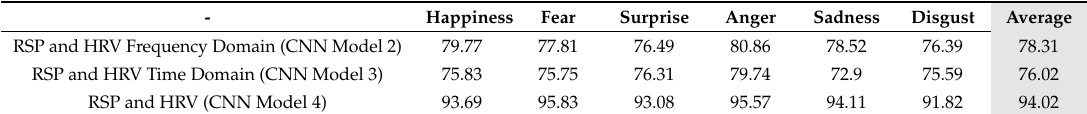
Table 6. Accuracy of multi-signal for six emotions